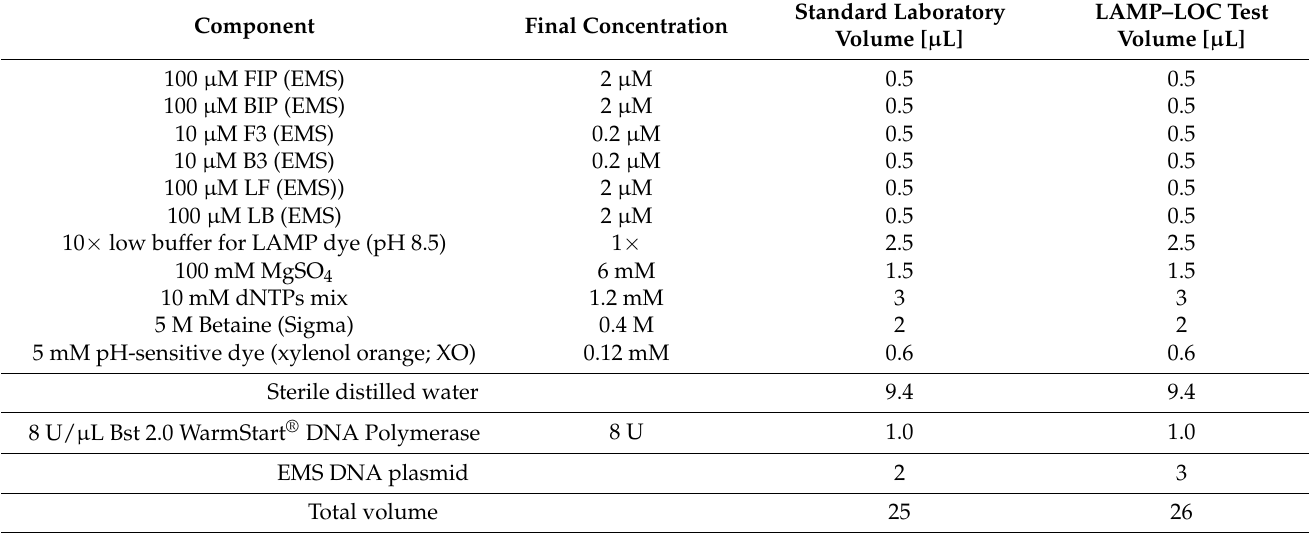
Table 3. LAMP reaction component for early mortality syndrome (EMS) detection by standard laboratory methods and EWOD